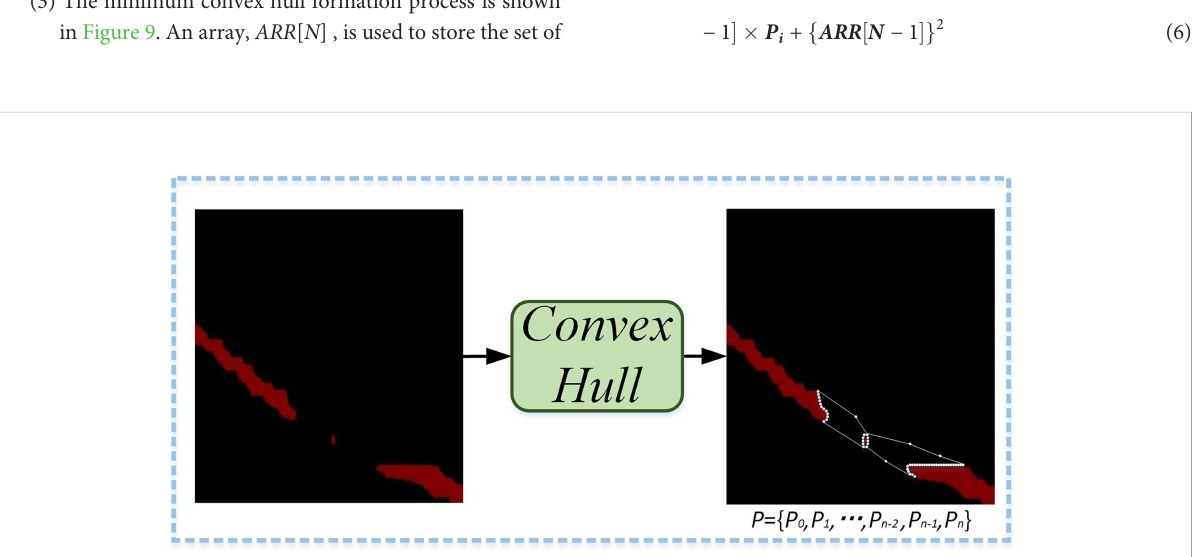
FIGURE 8 Minimum convex polygonal construction diagram. A minimum convex polygon is formed by the edge vertices of the leaf veins ’ incomplete segmentation regions, the noise points between regions, and small isolated